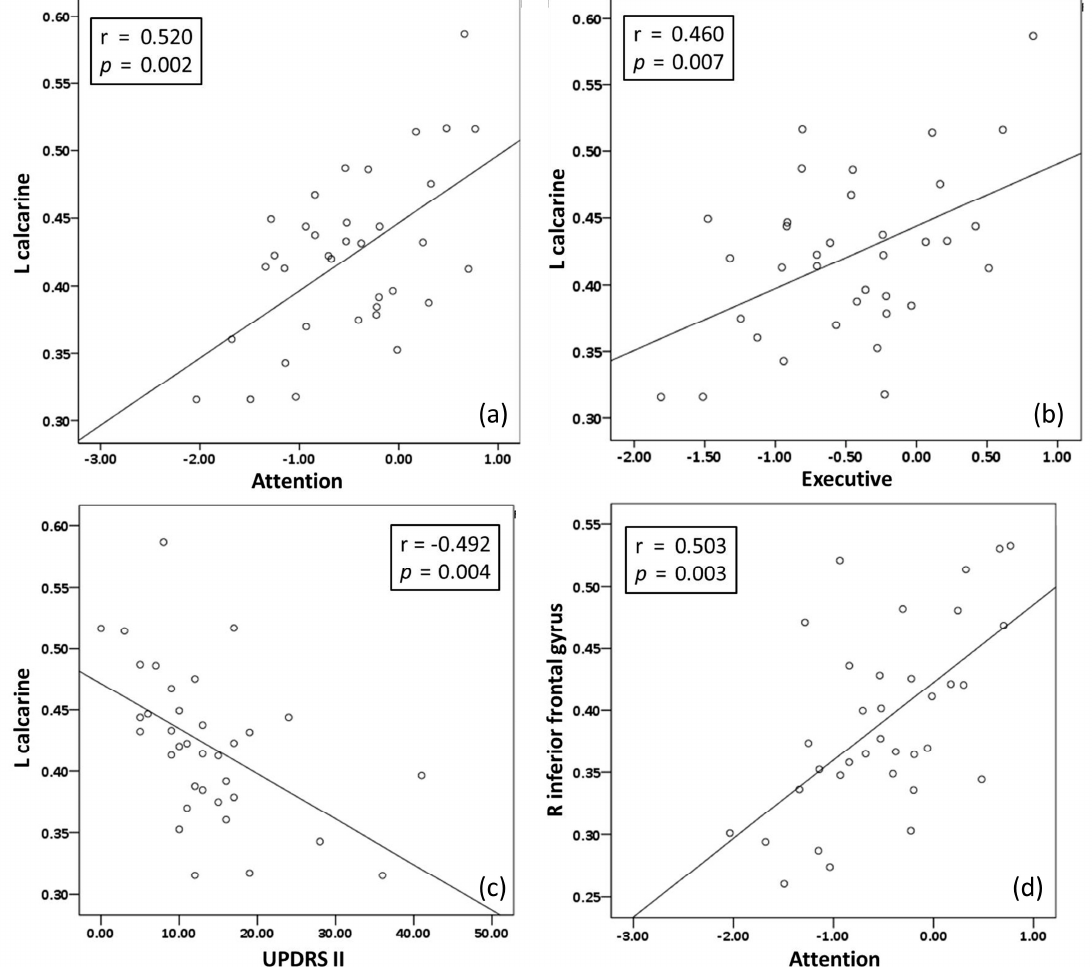
Figure 2. Correlations between NP tests (attention and executive) and UPDRS-II and regional GMV. ( a ) Left calcarine and attention. ( b ) Left calcarine and executive. ( c ) left calcarine and UPDRS-II. ( d ) Right inferior frontal gyrus and